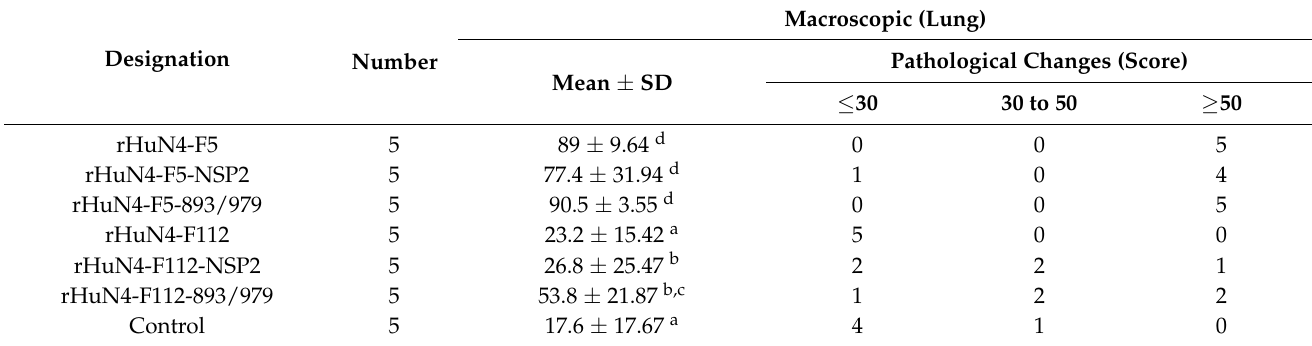
Table 2. Mean values ( ± SD) of macroscopic scores of lung tissues after infection.